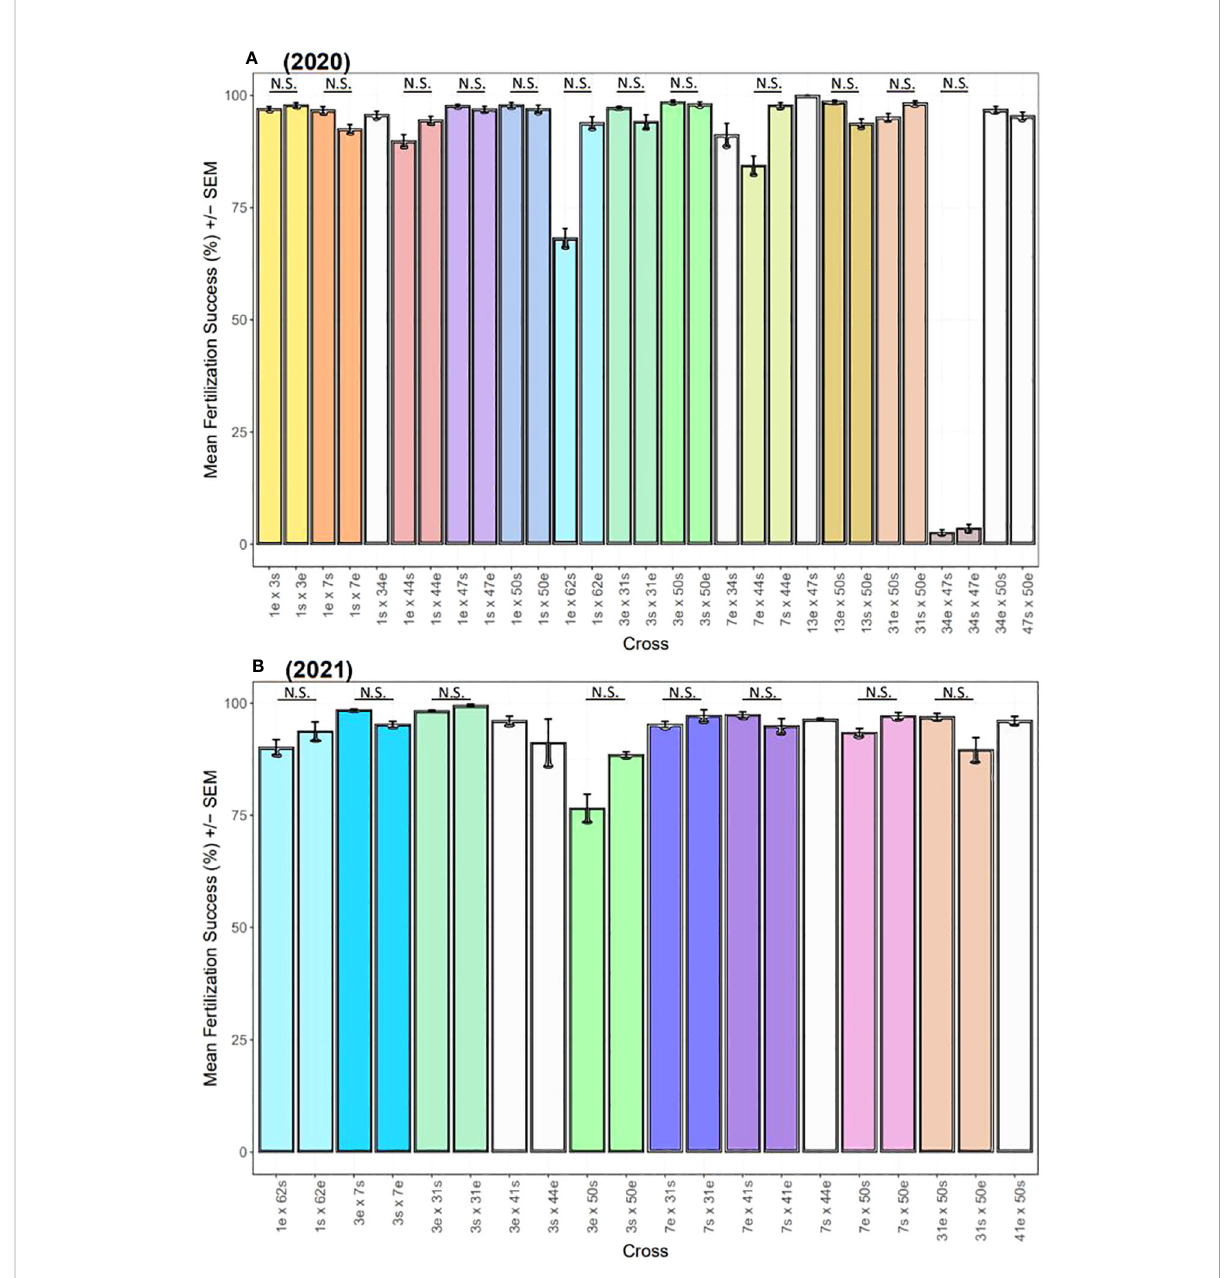
FIGURE 8 Fertilization success of two-parent A. cervicornis controlled crosses across two years. Dams (mothers) and sires (fathers) are indicated by ‘ e ’ (egg donor) and ‘ s ’ (sperm donor), respectively. (A) In 2020, there were signi fi cant differences in fertilization success (mean % ± SEM) across the 29 two-parent crosses (statistics in text), but no signi fi cant differences ( ‘ N.S. ’ ) were found between the 12 pairs of direct and reciprocal crosses. Excluding 34 x 47, overall fertilization success was ~96%. (B) In 2021, there were signi fi cant differences in fertilization success (mean % ± SEM) across the 20 two-parent crosses (statistics in text), but no signi fi cant differences ( ‘ N.S. ’ ) were found between the 8 pairs of direct and reciprocal crosses. Overall fertilization success was ~95%. In both plots, direct and reciprocal crosses are paired by color, uni-directional crosses are white, and the 2020 crosses repeated in 2021 have the same color